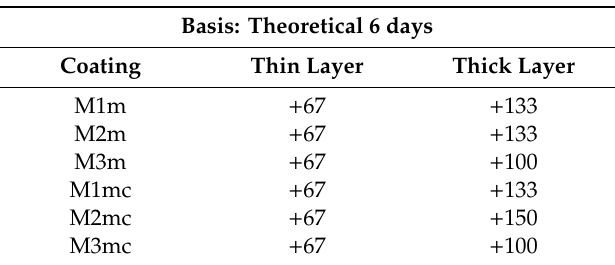
Table 3. The experimental consumption time expressed as percentage (and in comparison with) of the theoretical consumption time for the examined coated